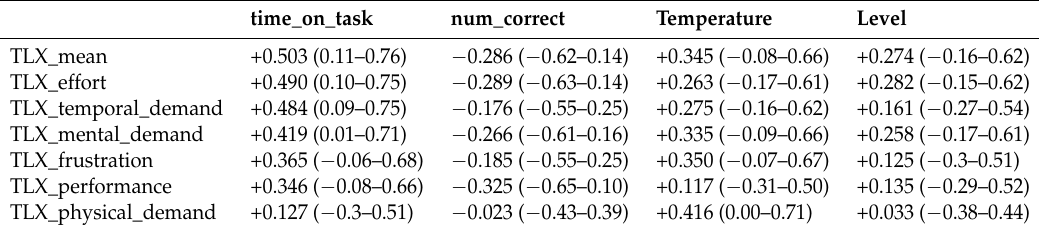
Table 4. Correlations between the TLX scores and objective cognitive load measures for the CogLoad dataset with 95% confidence interval in parentheses.